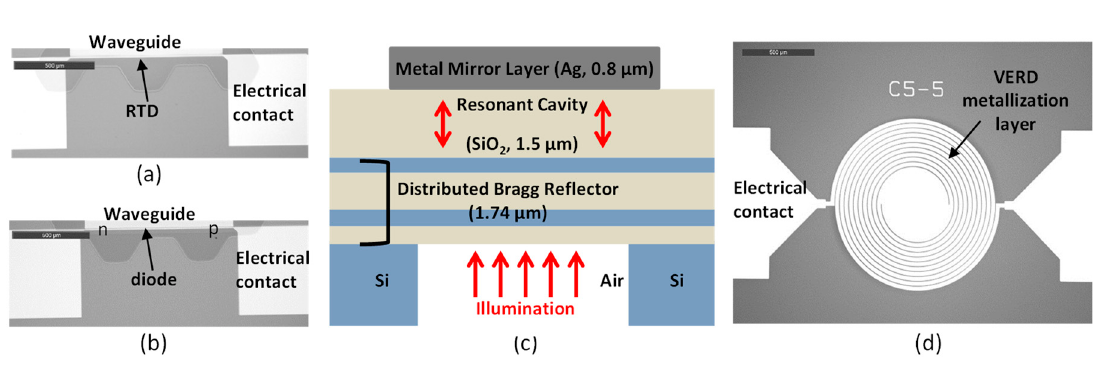
Figure 1. Overview about different detector designs. ( a ) RTD, based on a n-Si wire; ( b ) Diode: p-n junction on a Si wire ( c ) VERD: Schematic cross-section through the layer stack and ( d ) silver meander structure for resistance